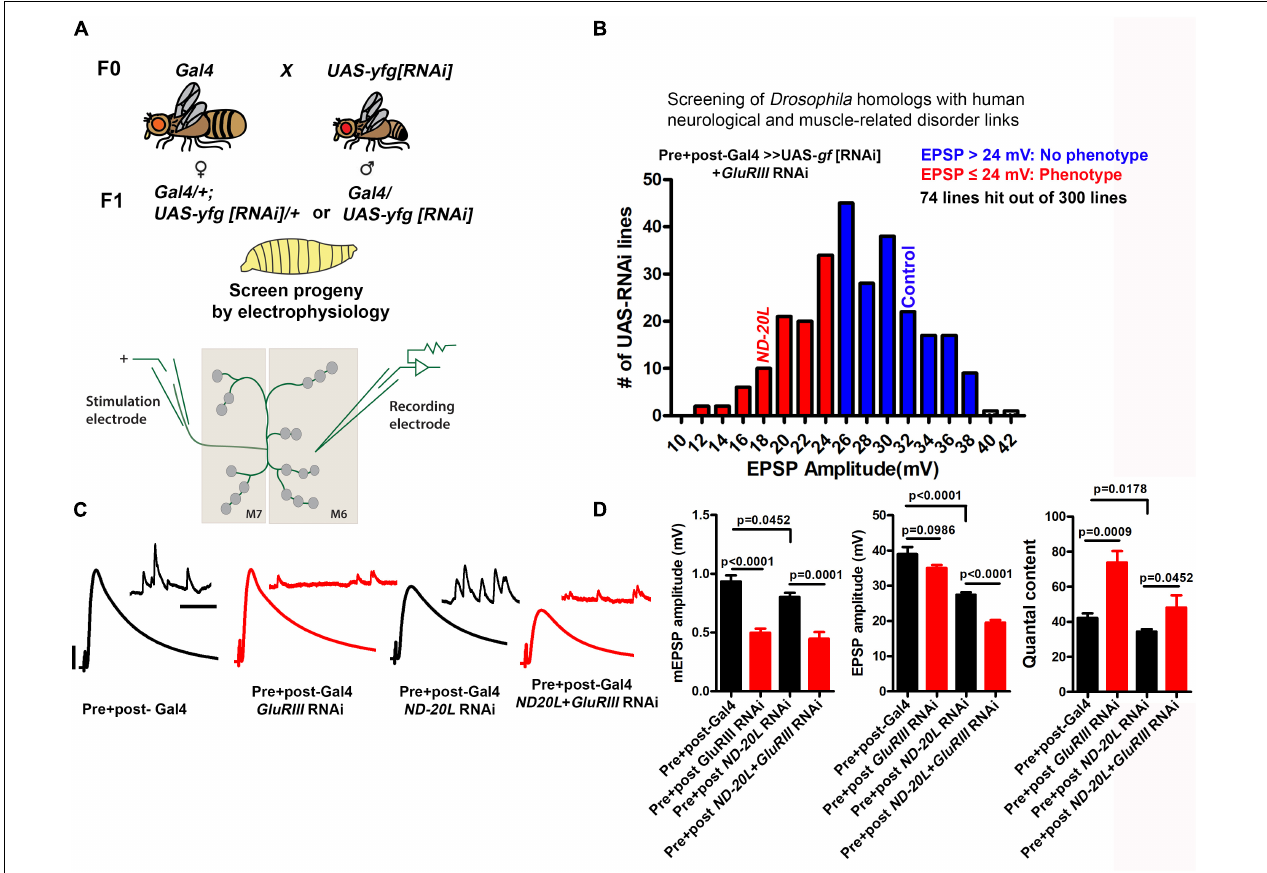
FIGURE 2 | An RNAi screen to identify genes involved in homeostatic synaptic plasticity for human neurological and muscle-related disorders in Drosophila . (A) Crossing scheme for screen. Presynaptic + Postsynaptic-Gal4; GluRIII [RNAi] × UAS-yfg [RNAi] ( yfg , “your favorite gene”). For UAS-RNAi lines on chromosomes II or III, male progeny were examined by electrophysiology because dosage compensated elaV(C155)-Gal4/Y male progeny should have a higher dose of pre-synaptic Gal4 than elaV(C155)-Gal4/ + female siblings. (B) The mean value of EPSP amplitudes for screened lines. The mean for the control cross x GluRIII[RNAi] = 35.22 mV ( Supplementary Table 1 , final row), and standard deviation for this control = 5.88 mV. For our analysis, we have included everything as a potential hit which fell roughly two standard deviations below the control mean amplitude or lower (23.46 mV, ∼ 24 mV or lower) ( Supplementary Table 1 ). Screen results are highlighted with red and blue bars in the histogram. EPSP cutoffs of ≤ 24 mV (red) were considered putative hits, and > 24 mV (blue) were considered normal ( Supplementary Table 1 ). The majority of knockdown experiments were performed at 29 ◦ C, except a few experiments (18 ◦ C because higher temperatures caused early lethality). Electrophysiology recordings were carried out at 25 ◦ C. (C) Representative electrophysiological traces for selected ND-20L or control genotypes in the presence and absence of GluRIII RNAi. Scale bars for EPSPs (mEPSPs) are x = 50 ms (1000 ms) and y = 10 mV (1 mV). (D) Quantification showing mEPSP, EPSPs amplitude and quantal content in pre + post-Gal4 (mEPSP: 0.93 ± 0.05, EPSP: 38.99 ± 2.02, QC: 42.20 ± 2.65), pre + post- GluRIII RNAi (mEPSP: 0.49 ± 0.03, EPSP: 35.08 ± 0.82, QC: 73.82 ± 6.52), pre + post ND-20L[RNAi] (mEPSP: 0.80 ± 0.03, EPSP: 27.44 ± 0.70, QC: 34.44 ± 1.34) and pre + post ND-20L + GluRIII RNAi (mEPSP: 0.44 ± 0.05, EPSP: 19.55 ± 0.68, QC: 48.18 ± 6.95). The data for pre + post ND-20L[RNAi] and pre + post ND-20L + GluRIII RNAi are also represented in the Supplementary Table 1 . Statistical analysis based on one-way ANOVA with Tukey’s post hoc test. Error bars represent mean ± s.e.m. p -values are indicated in the